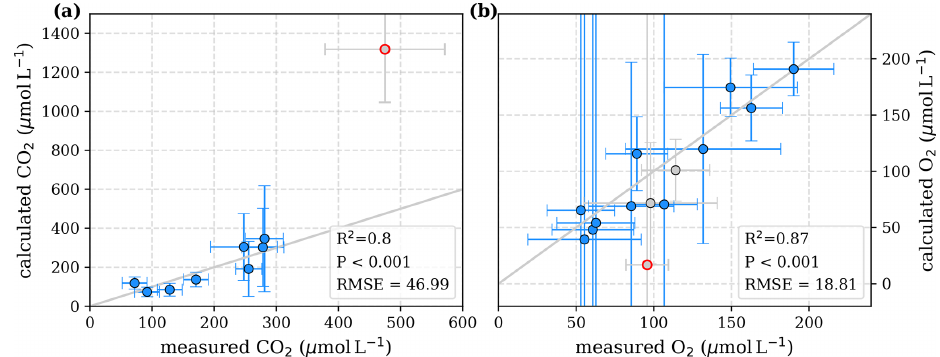
Figure D2. Correlation between measured and calculated concentrations of (a) CO 2 and (b) O 2 . Grey lines indicate the 1 : 1 line. Calculations were performed based on the equations in Table 1, which represent linear pH limitation of decomposition rates. Each data point represents one river. Grey data points are excluded from the correlation since the data for these rivers are based on fewer than three campaigns within the same season. The Simunjan campaigns with high carbon concentrations (Simunjan 2 , Table 4) are indicated by red